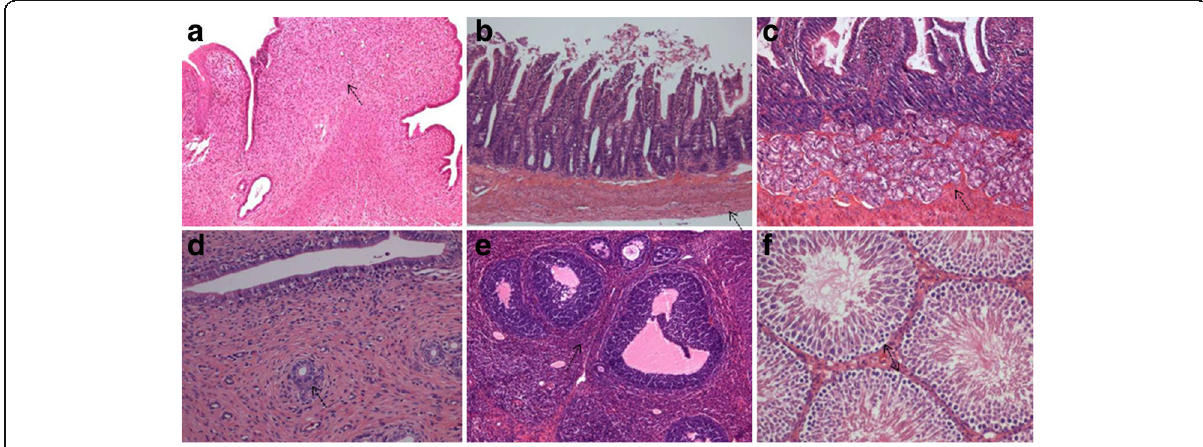
Fig. 13 Histopathological analysis of organs stained with H&E. Histopathology showing normal morphology from control group. a stomach, b jejunum, c duodenum, d uterus, e ovaries, f orchis; scale bar = 100 μ